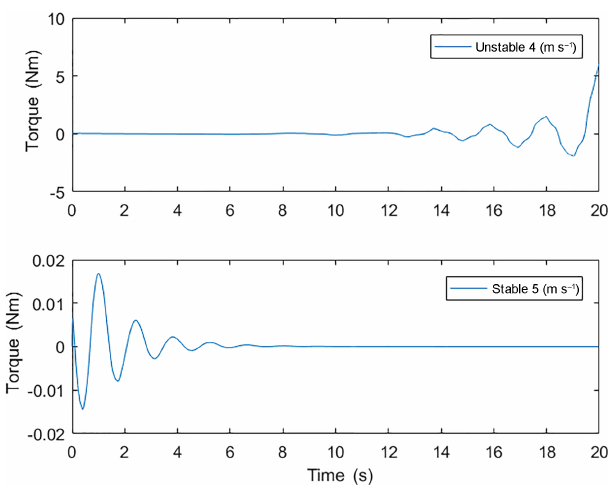
Figure 7. Estimated haptic steer feedback torque based on angular acceleration output ¨ δ , of the benchmark bicycle model for a steer torque input of